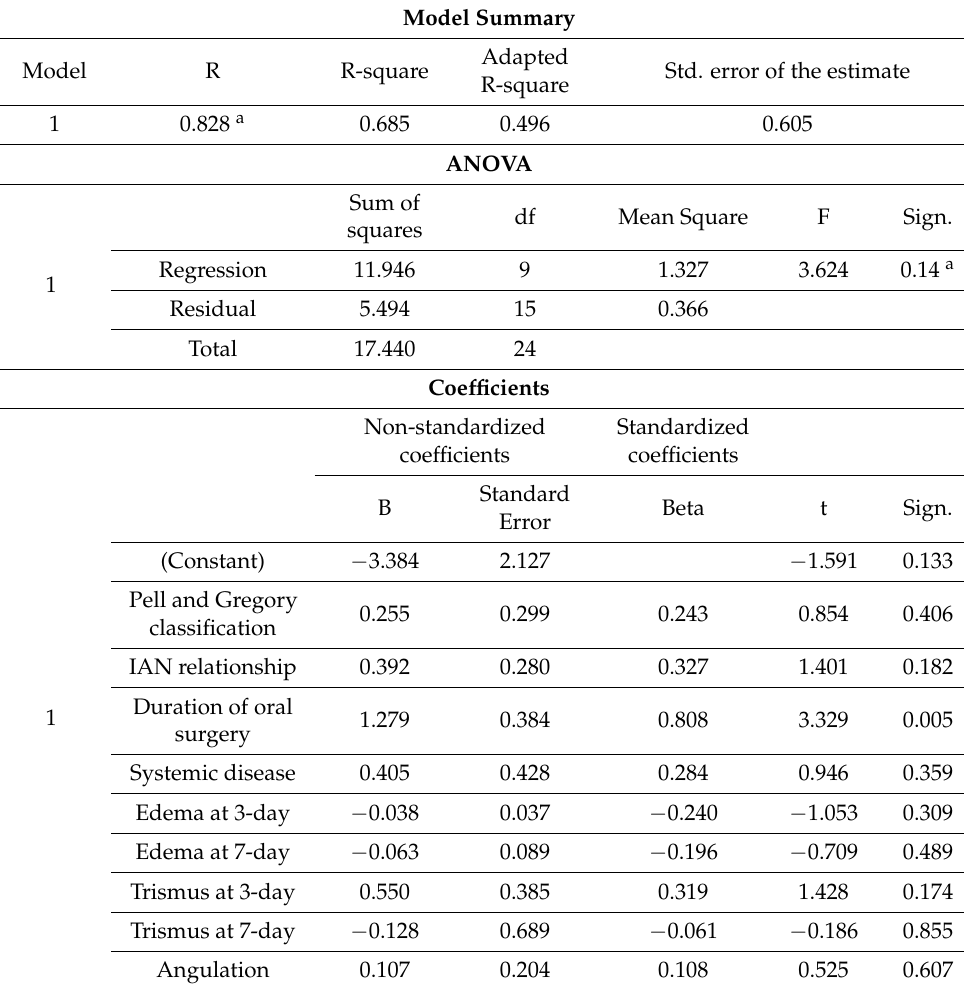
Table 8. Correlation between VAS scores at 6 h and patient- and tooth-related